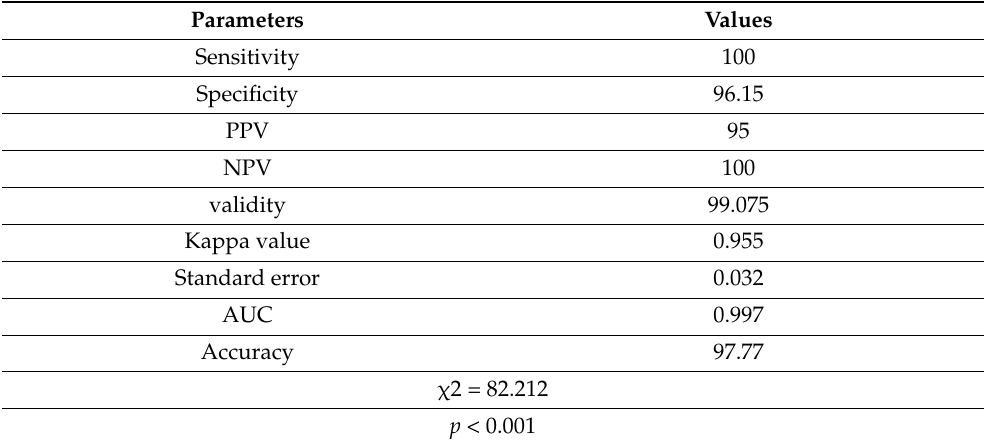
Table 6. Calculation of sensitivity and specificity of Cattle Toxo IgG ELISA kit against Gold Stand- ard ELISA kit (Commercial ELISA kit) ( n = 90).